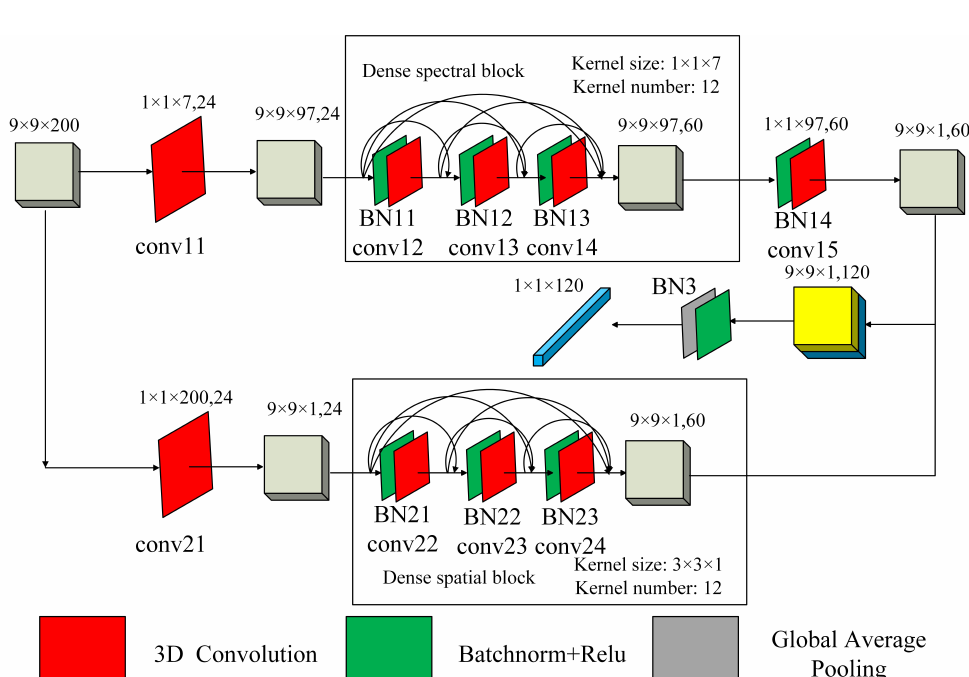
Figure 3. The architecture of our backbone CNN